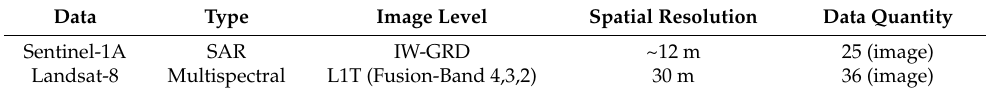
Table 1. The experimental data of remote sensing images used in this